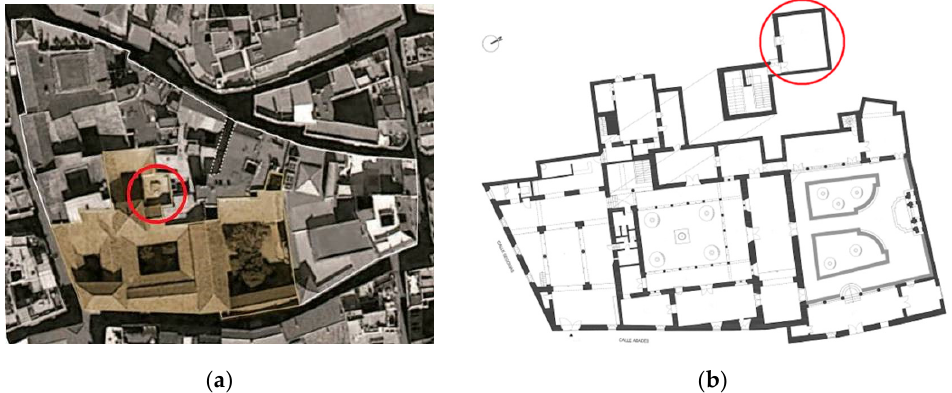
Figure 1. ( a ) Modern aerial photograph of the Pinelo Palace and its surroundings (overview through Google Earth). ( b ) Ground floor and mezzanine (indicated by the red circle). Authors’ own drawing, 2020.